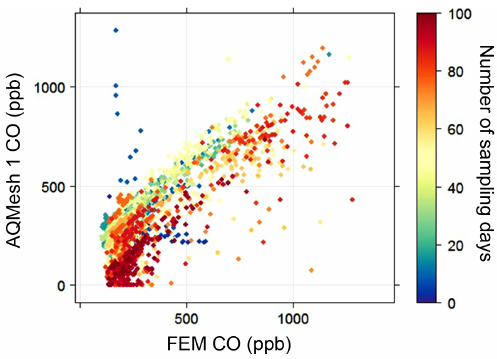
Figure 3. AQMesh vs. FEM carbon monoxide comparison, with markers colored by the number of days of sensor use.